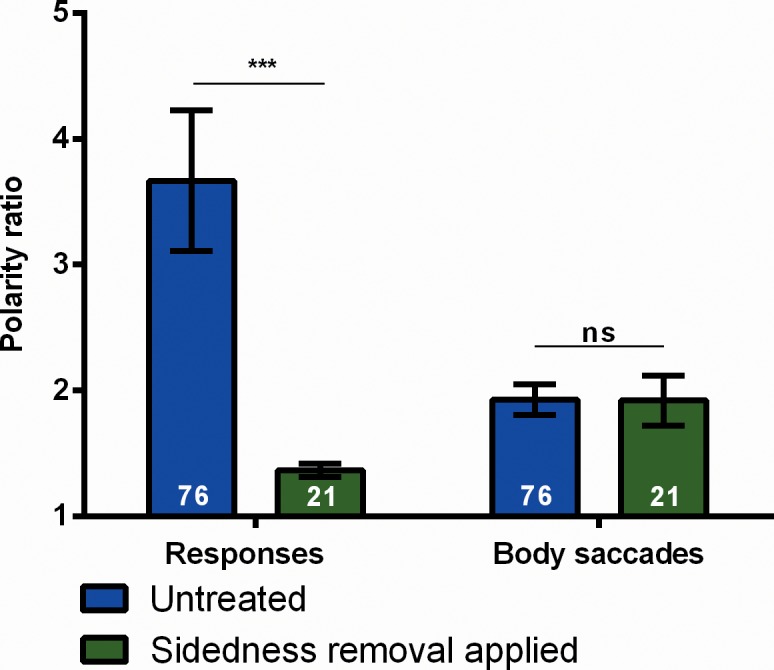
Polarity ratio (cw / ccw) of responses and body saccades (during ITIs).For each fly a polarity ratio is calculated as the number of spikes of the more frequent polarity divided by the number of spikes of the less frequent polarity. Numbers in the bars indicate N of flies. Whereas the polarity ratio of responses is susceptible to the removal of sidedness, that of body saccades is not (see Methods for details). Error bars are SEMs over flies (*P < 0.05, **P < 0.01, ***P < 0.001).